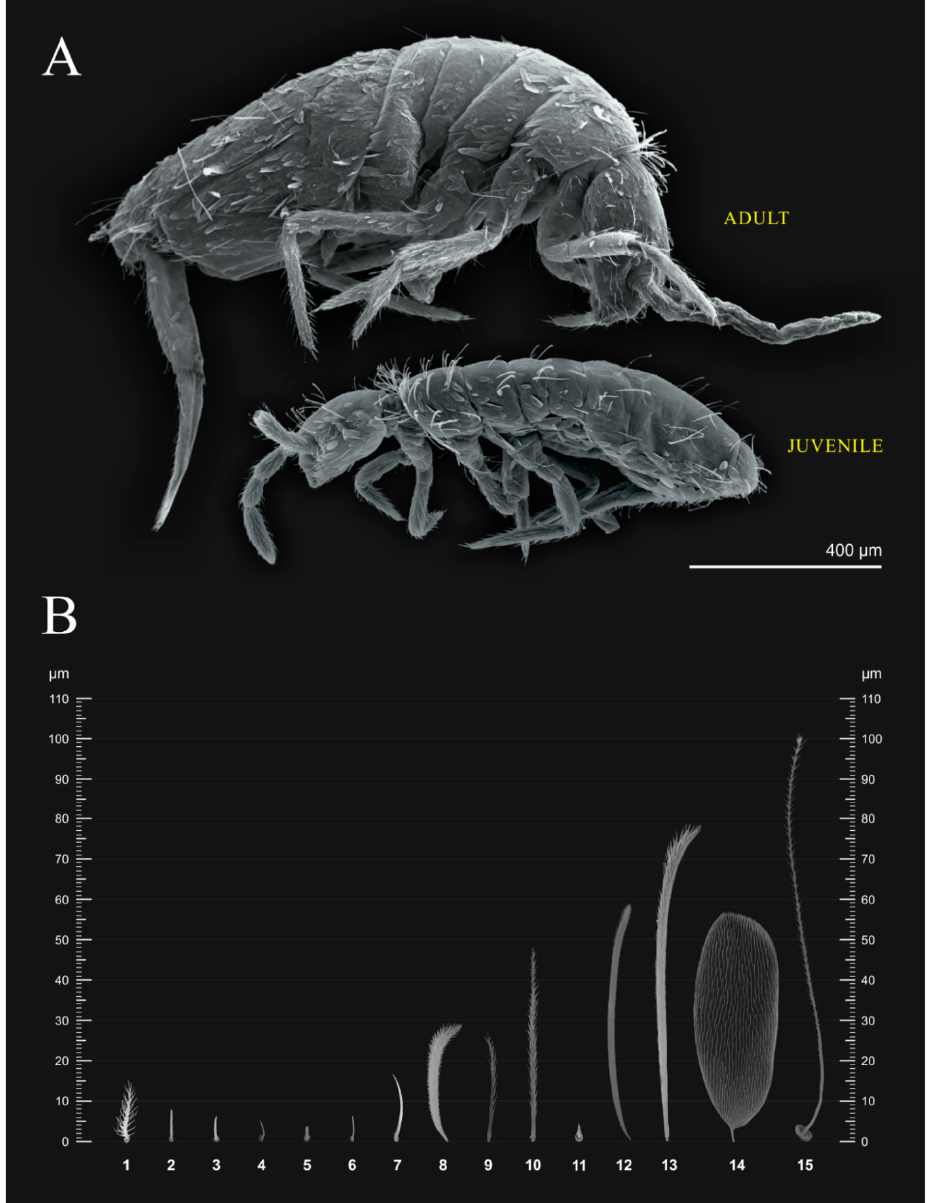
Figure 6. Seira musarum SEM (lateral view) . ( A ). Habitus adult and juvenile; ( B ), general body chaetae; ( B1 ), microchaeta with long ciliation; ( B2 ), wrinkly sens; ( B3 ), finger-shaped sens; ( B4 ), microchaetae smooth; ( B5 ), rod sens; ( B6 ), smooth microchaeta; ( B7 ), serrate chaetae; ( B8 ), fan-shape chaeta; ( B9 ), chaetae ciliated; ( B10 ), strait macrochaeta with long ciliation; ( B11 ), labial r macrochaetae; ( B12 ), macrochaetae ciliated with rounded apex; ( B13 ), macrochaetae ciliated with trucated apex; ( B14 ), ordinary scale; ( B15 ), bothriotrichum.